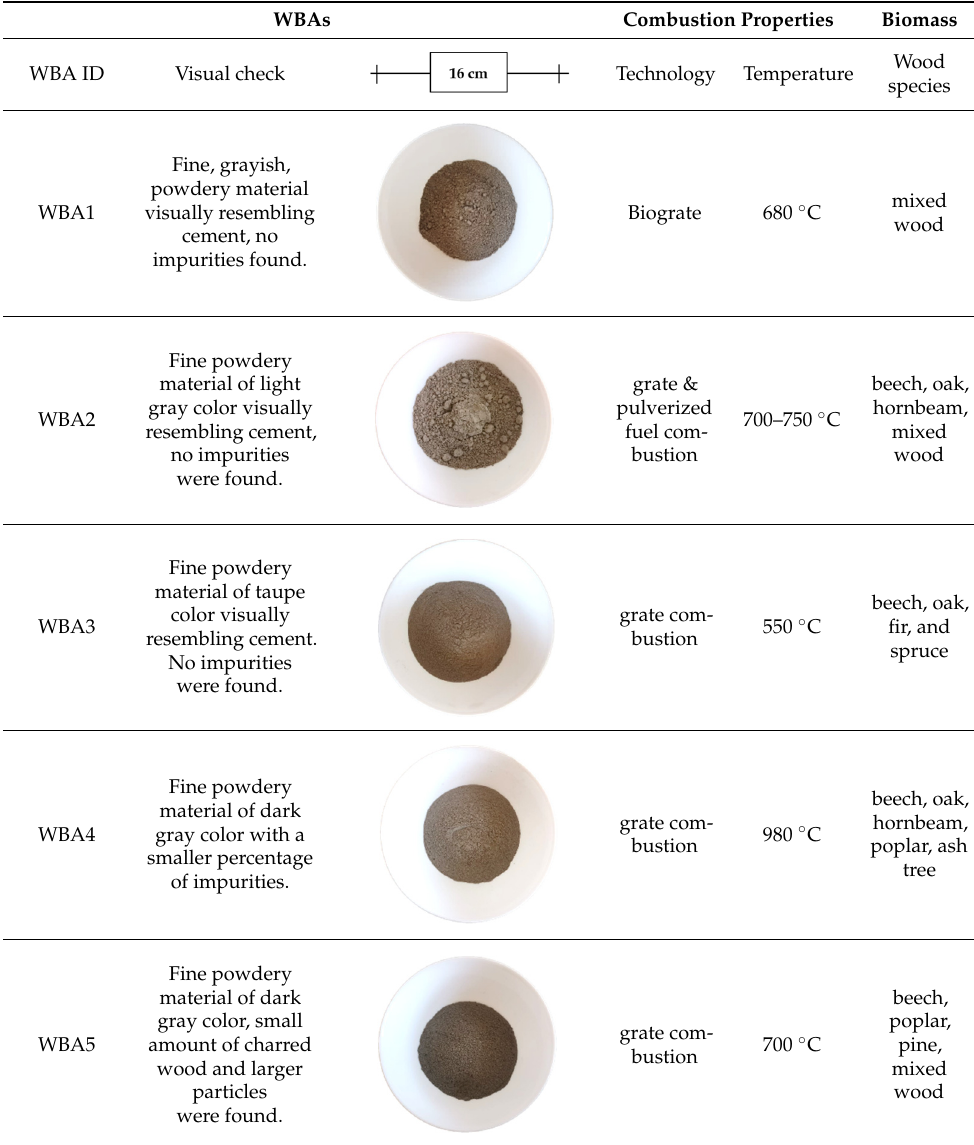
Table 1. Properties of fly WBAs and the origin of power plants.